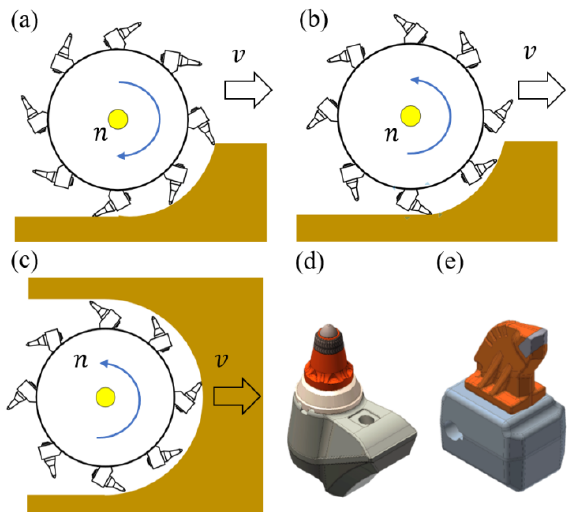
Figure 3. Cutting modes and cutter bits types: ( a ) up-milling mode, ( b ) climb-milling mode, ( c ) slot- milling mode (lateral view of the cutter head) ( d ) conical cutters (BETEK) ( e ) radial cutters (BETK).